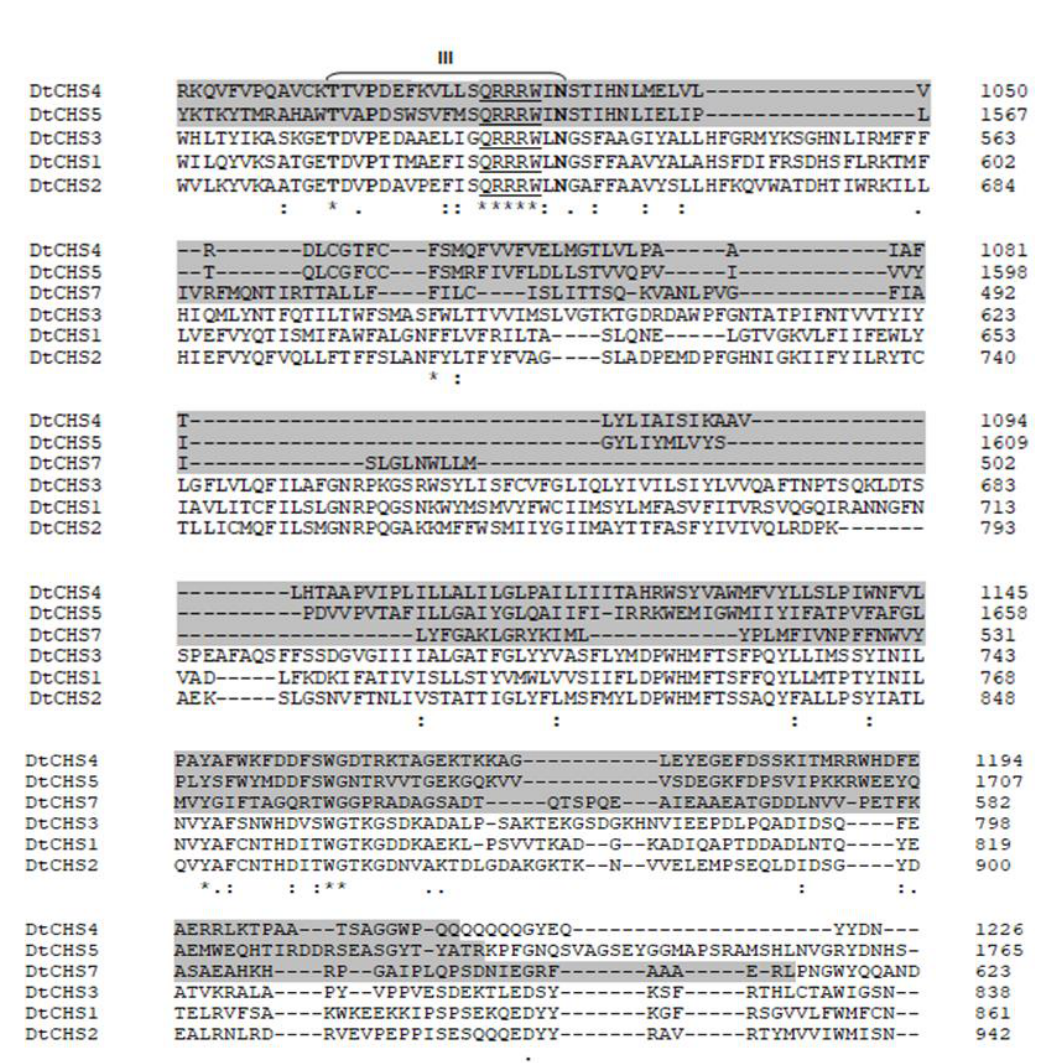
Figure 4. Partial amino acid sequence alignment of the six D. teres CHSs showing the conserved chitin synthase domain (highlighted) and “QRRRW” / “EDR” motifs (underlined). Amino acids indicated with bold characters are those conserved in all CHSs listed here. I-III represent subdomains where conserved amino acids appear at high frequencies.